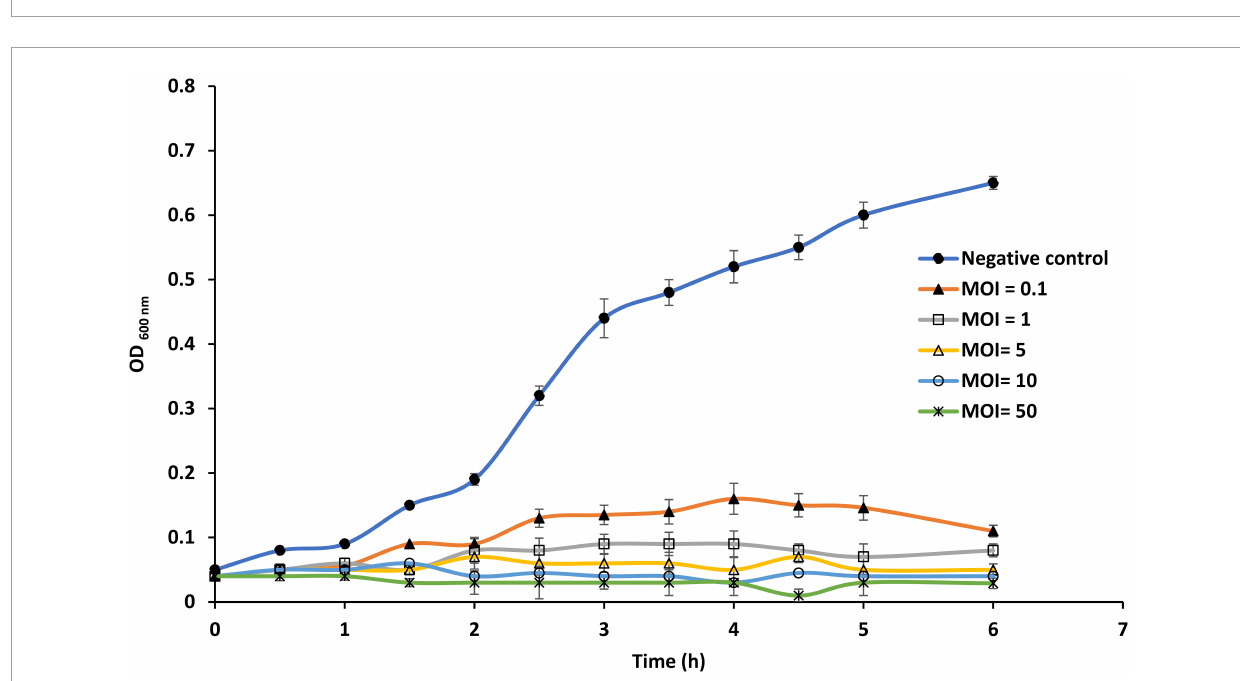
FIGURE6 In vitro virulence of phage LPSent1 on free planktonic cells of S . Enteritidis EG.SmE1 at different multiplicity of infections (MOIs). The lysis activity of phage LPSent1 was evaluated at MOIs of 0.1, 1, 5, or 10. Bacterial cells were incubated for 24 h at 37 ◦ C, bacterial growth was monitored for 6 h by measuring optical density at 600 nm using a microplate reader (680 XR reader, Bio-Rad, Hercules, CA, USA). Data shown are the means of three replicates and error bars show the standard deviation in the values.